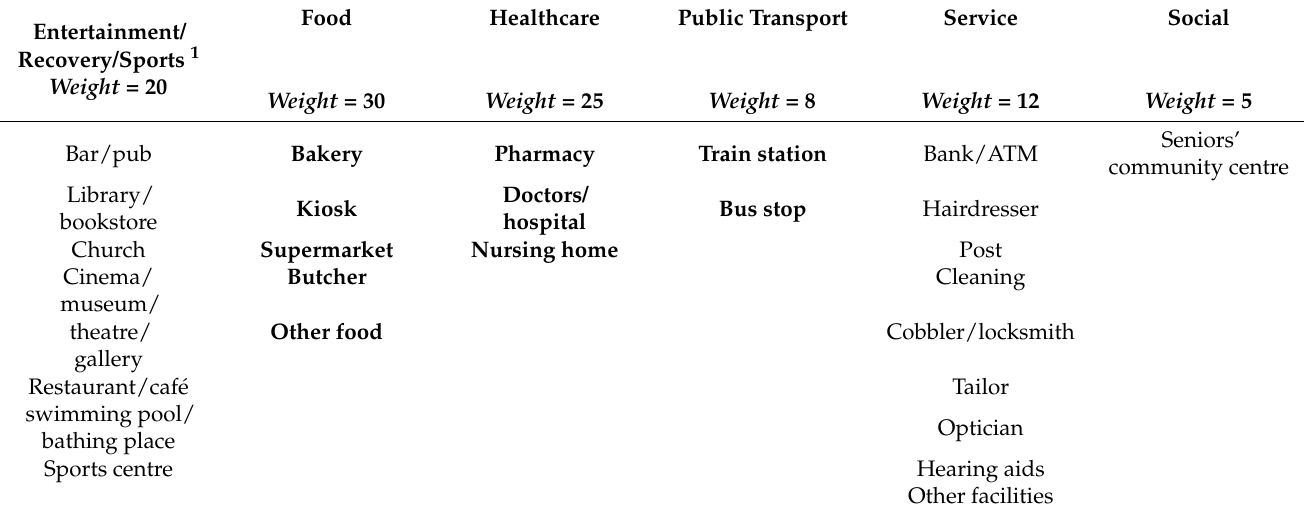
Table 1. Supply facility